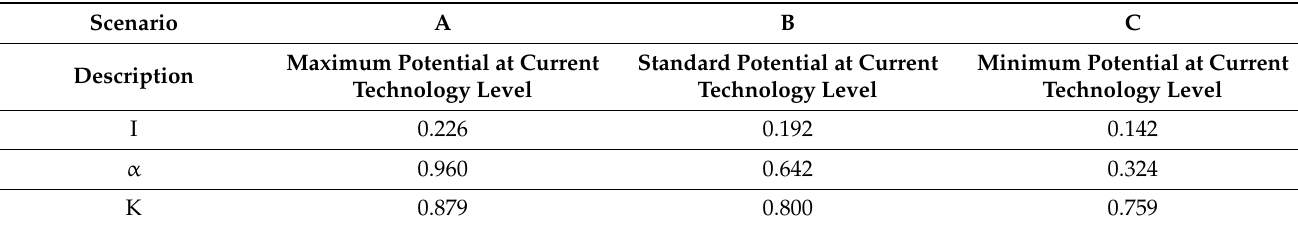
Table 3. Three scenarios of variable coefficients I, α , and